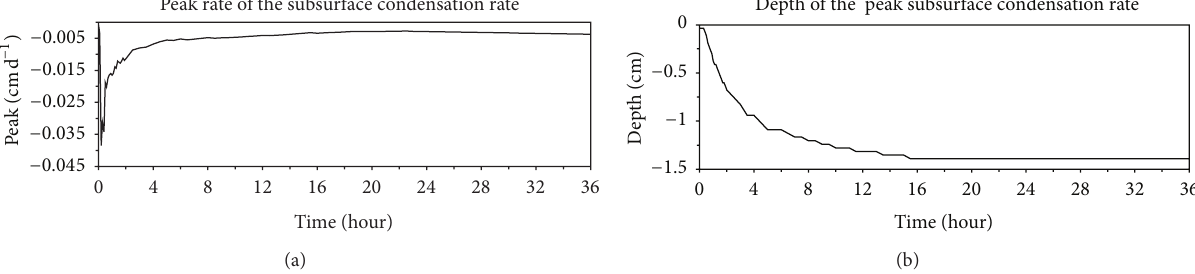
Figure 7: Temporal changes in peaks of subsurface condensation rate (a) and its locations (b) in the subsurface evaporation rate profile.